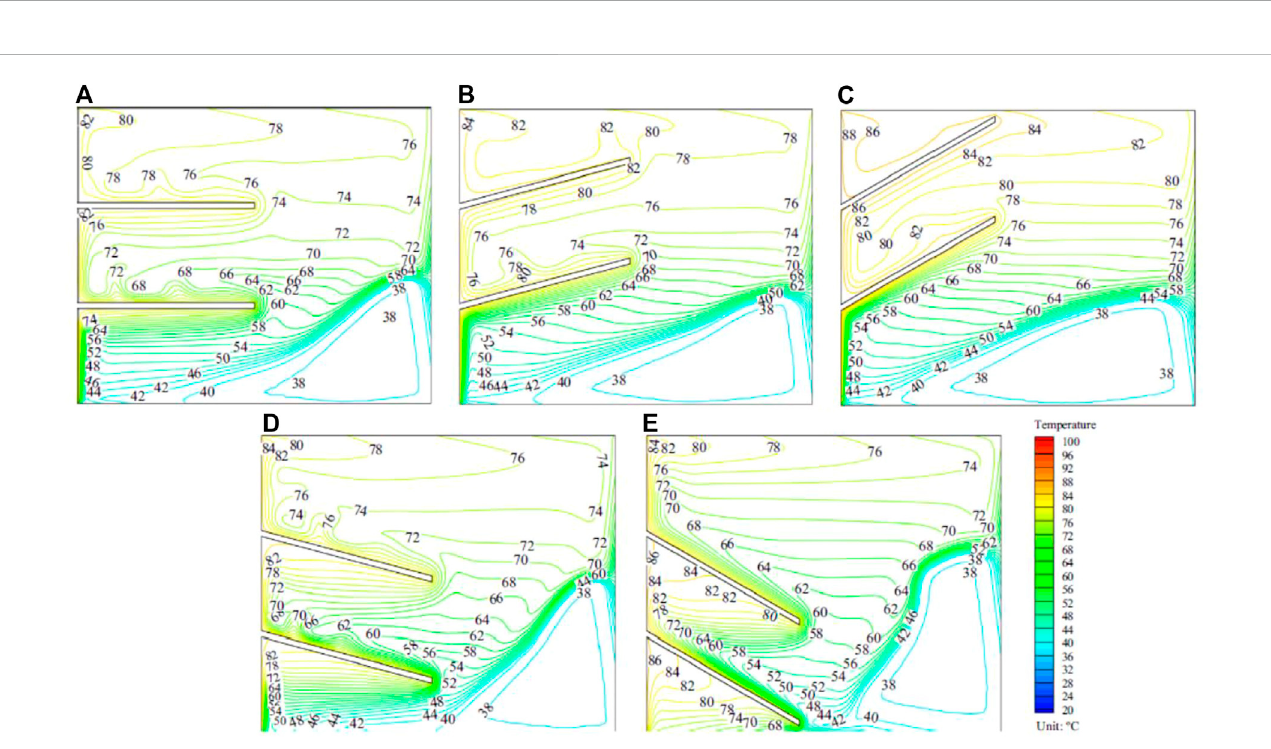
FIGURE 16 Temperature contours lines inthePCM domain att= 10,000 s: (A) θ = 0 ° ; (B) θ =15 ° ; (C) θ = 30 ° ; (D) θ = − 15 ° and (E) θ = − 30 ° ,with the fi xeddimensionless fi n length l/L = 0.5 and heat fl ux input q n = 2500W/m 2 (Ji et al.,